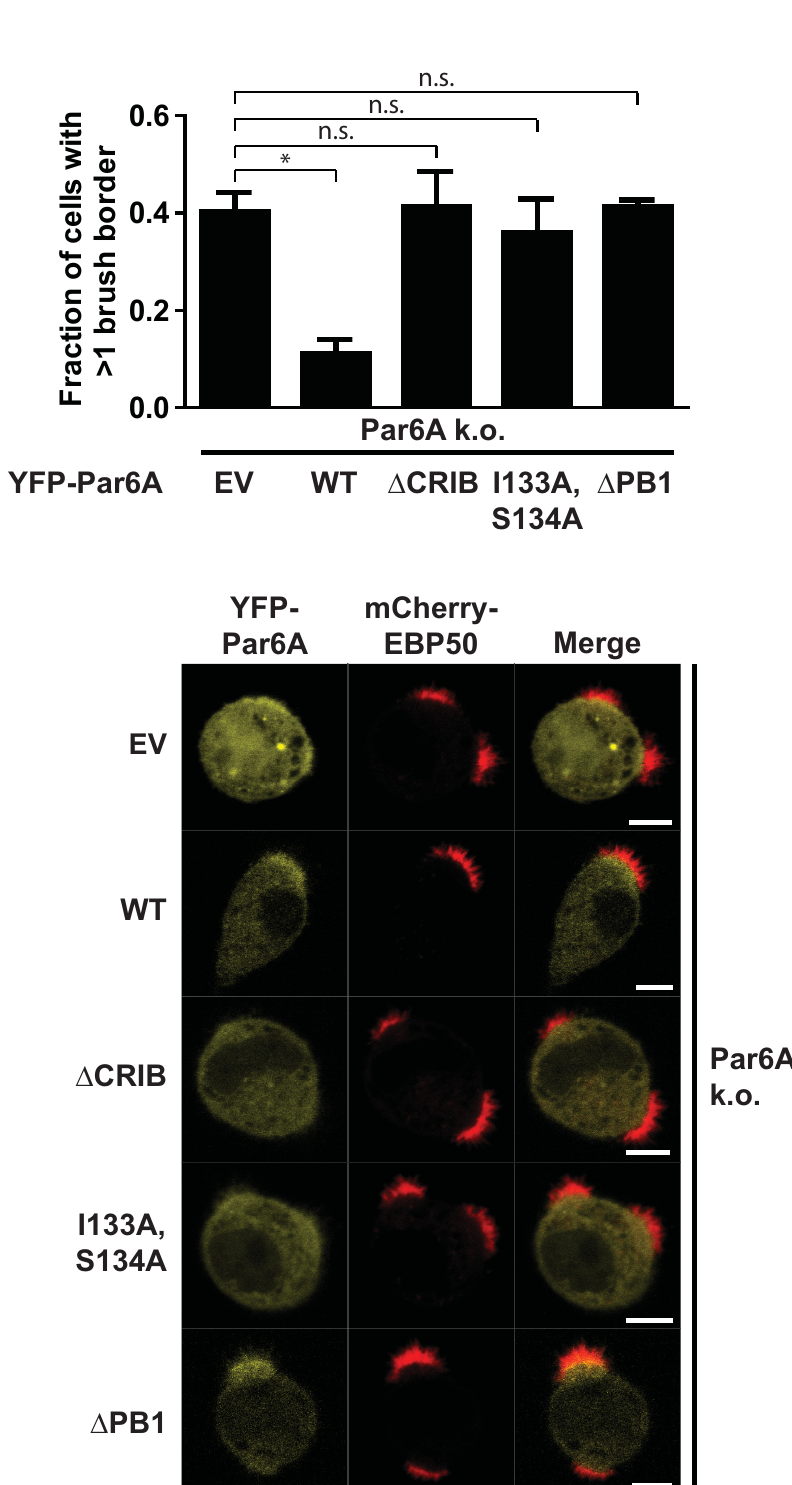
Fig 4. Cdc42-binding defective and PB1 deletion mutants of Par6A can not rescue singularity in apical membrane in Par6A k.o. cells. A) Quantification of the fraction of cells that form more than one brush border as determined by mCherry-EBP50 distribution in Par6A k.o. cells expressing YFP empty vector (EV) or YFP-Par6A(WT), YFP-Par6A ( Δ CRIB), YFP-Par6A(I133A,S134A) or YFP-Par6A( Δ PB1). Error bars indicate sd (n � 3, > 85 cells in total per